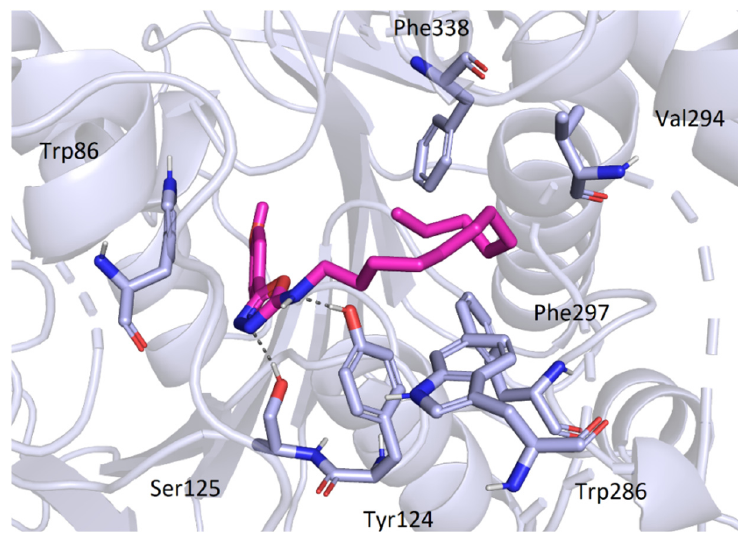
Figure 6. Binding mode of the compound 3c in AChE.